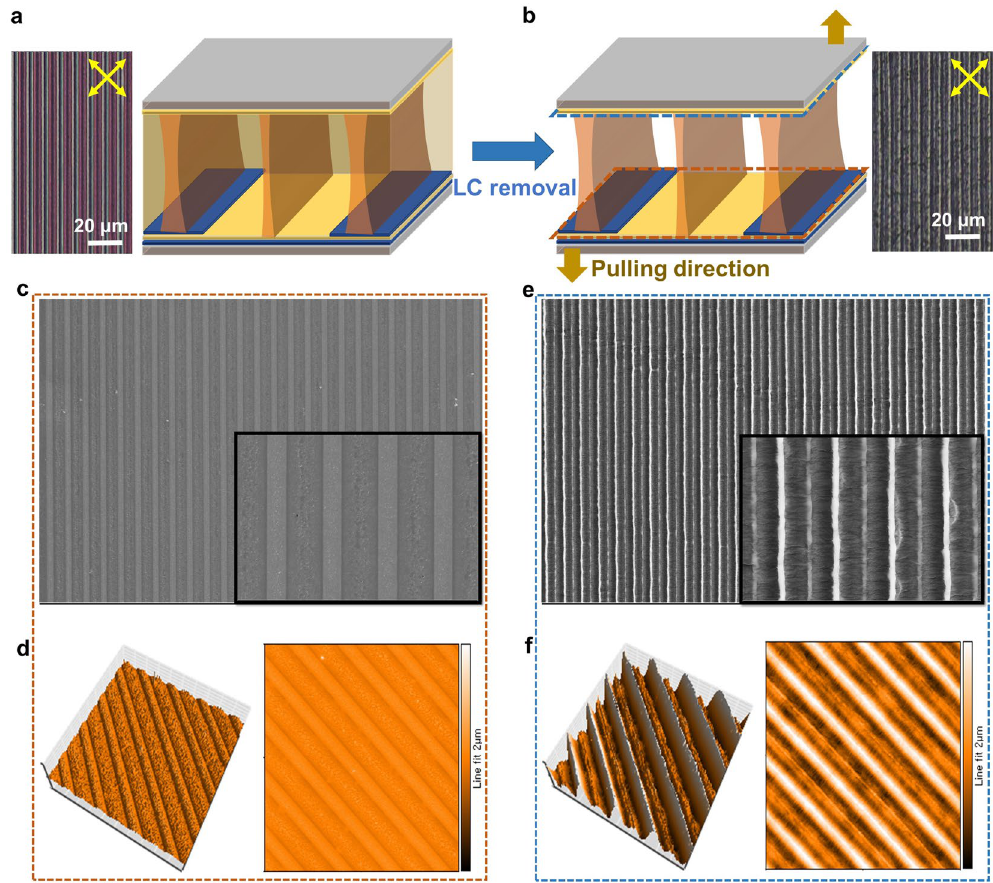
Figure 3. POM images and cell structures ( a ) before and ( b ) after removal of LCs. ( c ) SEM and ( d ) AFM images of the separated bottom substrate. ( e ) SEM and ( f ) AFM images of the separated top substrate. The insets in ( c ) and ( e ) present magnified views of the SEM